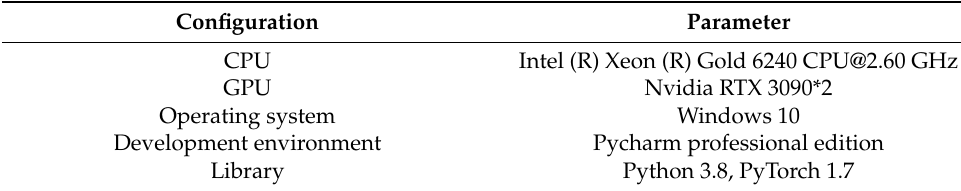
Table 1. Experimental